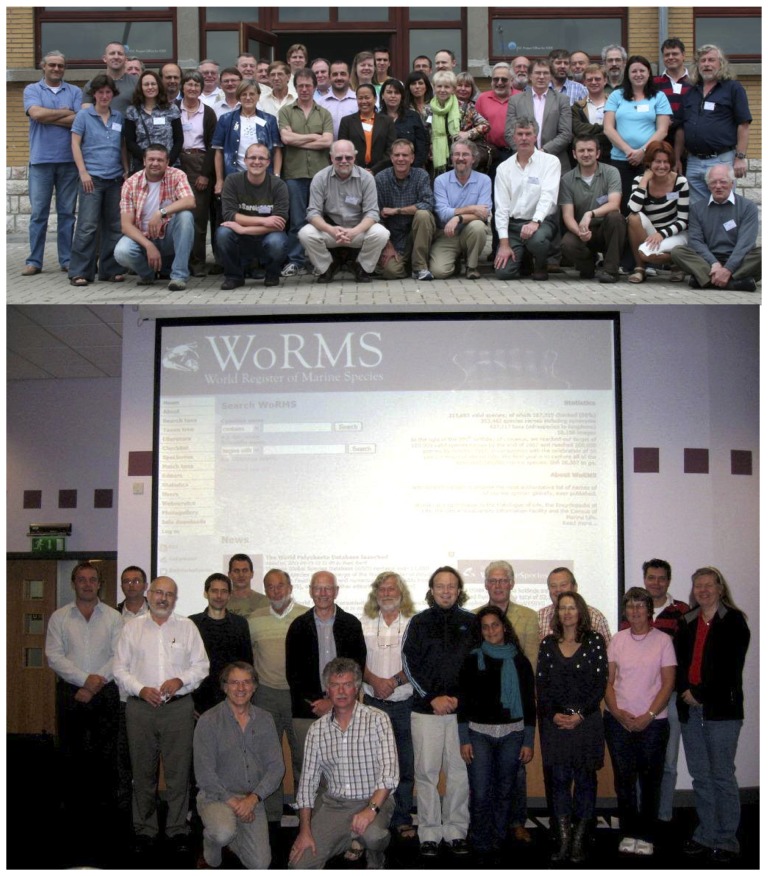
Some of the WoRMS editors at workshops in Ostend in 2008 (upper panel) and Aberdeen in 2011.